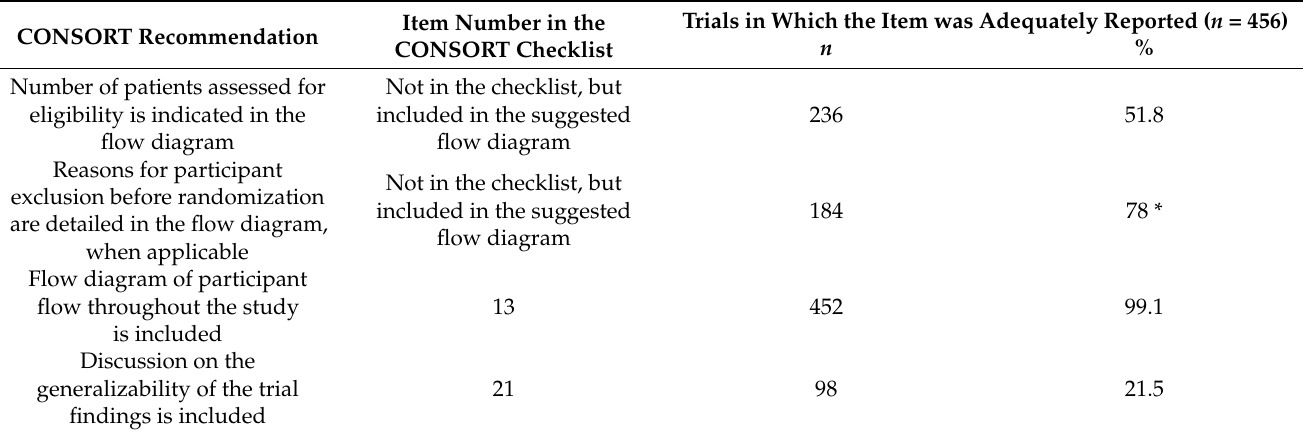
Table 1. Quality of reporting of parameters of external validity from the 2010 CONSORT